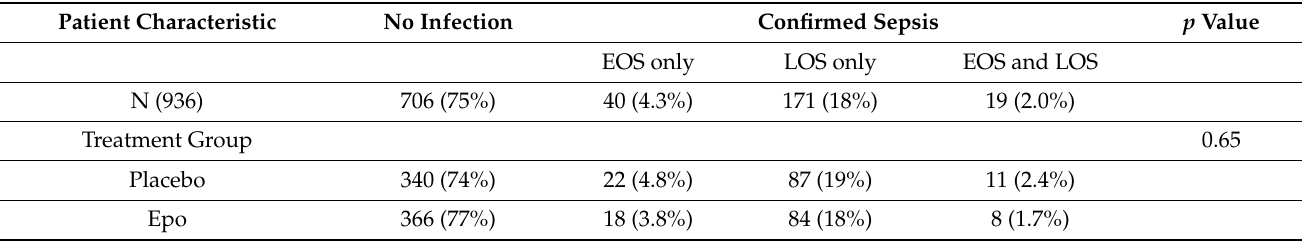
Table 1. Demographics by timing of confirmed